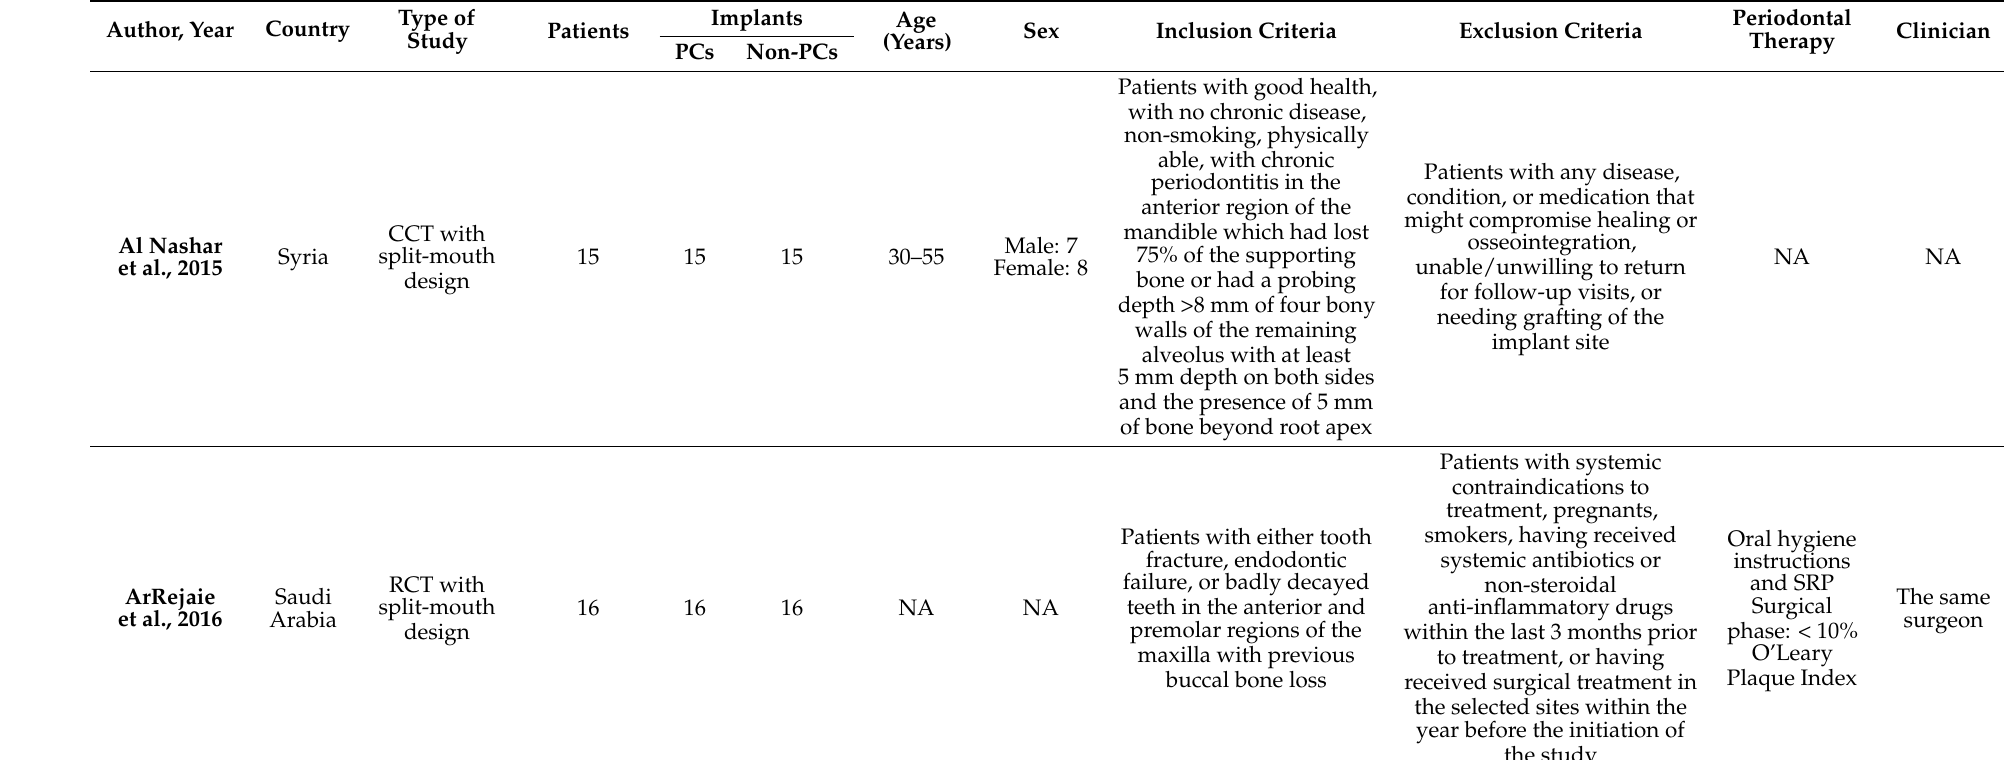
Table 2. General characteristics of the selected